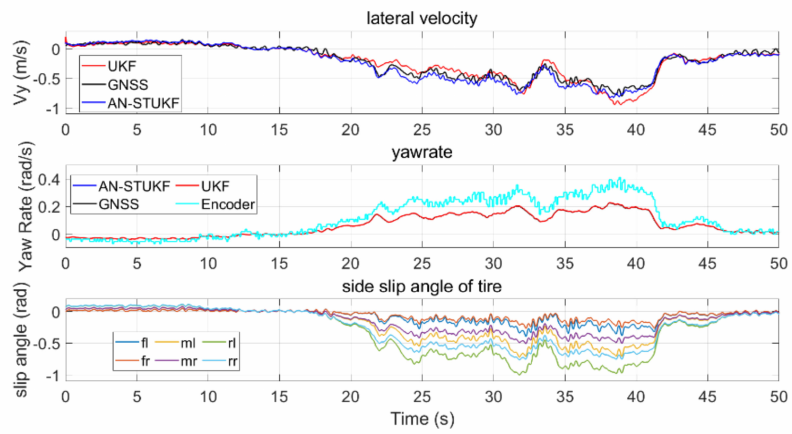
Figure 10. The lateral state when a skid-steered wheeled vehicle turns in a small radius. The lateral velocity estimation result by AN-STUKF is more accurate than the re- sults estimated by the traditional UKF. The AN-STUKF shows higher accuracy than the traditional UKF when the vehicle drives in strong nonlinear conditions.